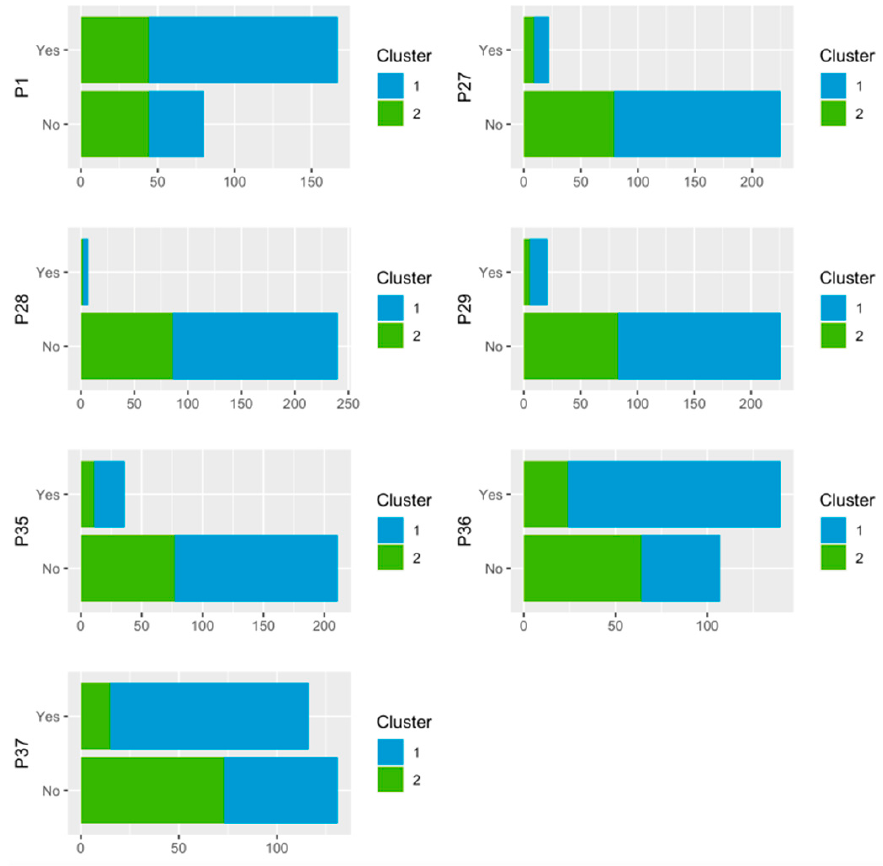
Figure 5. Summary of responses by cluster to questions with categorical responses from two cate- gories. Source: compiled by the authors.